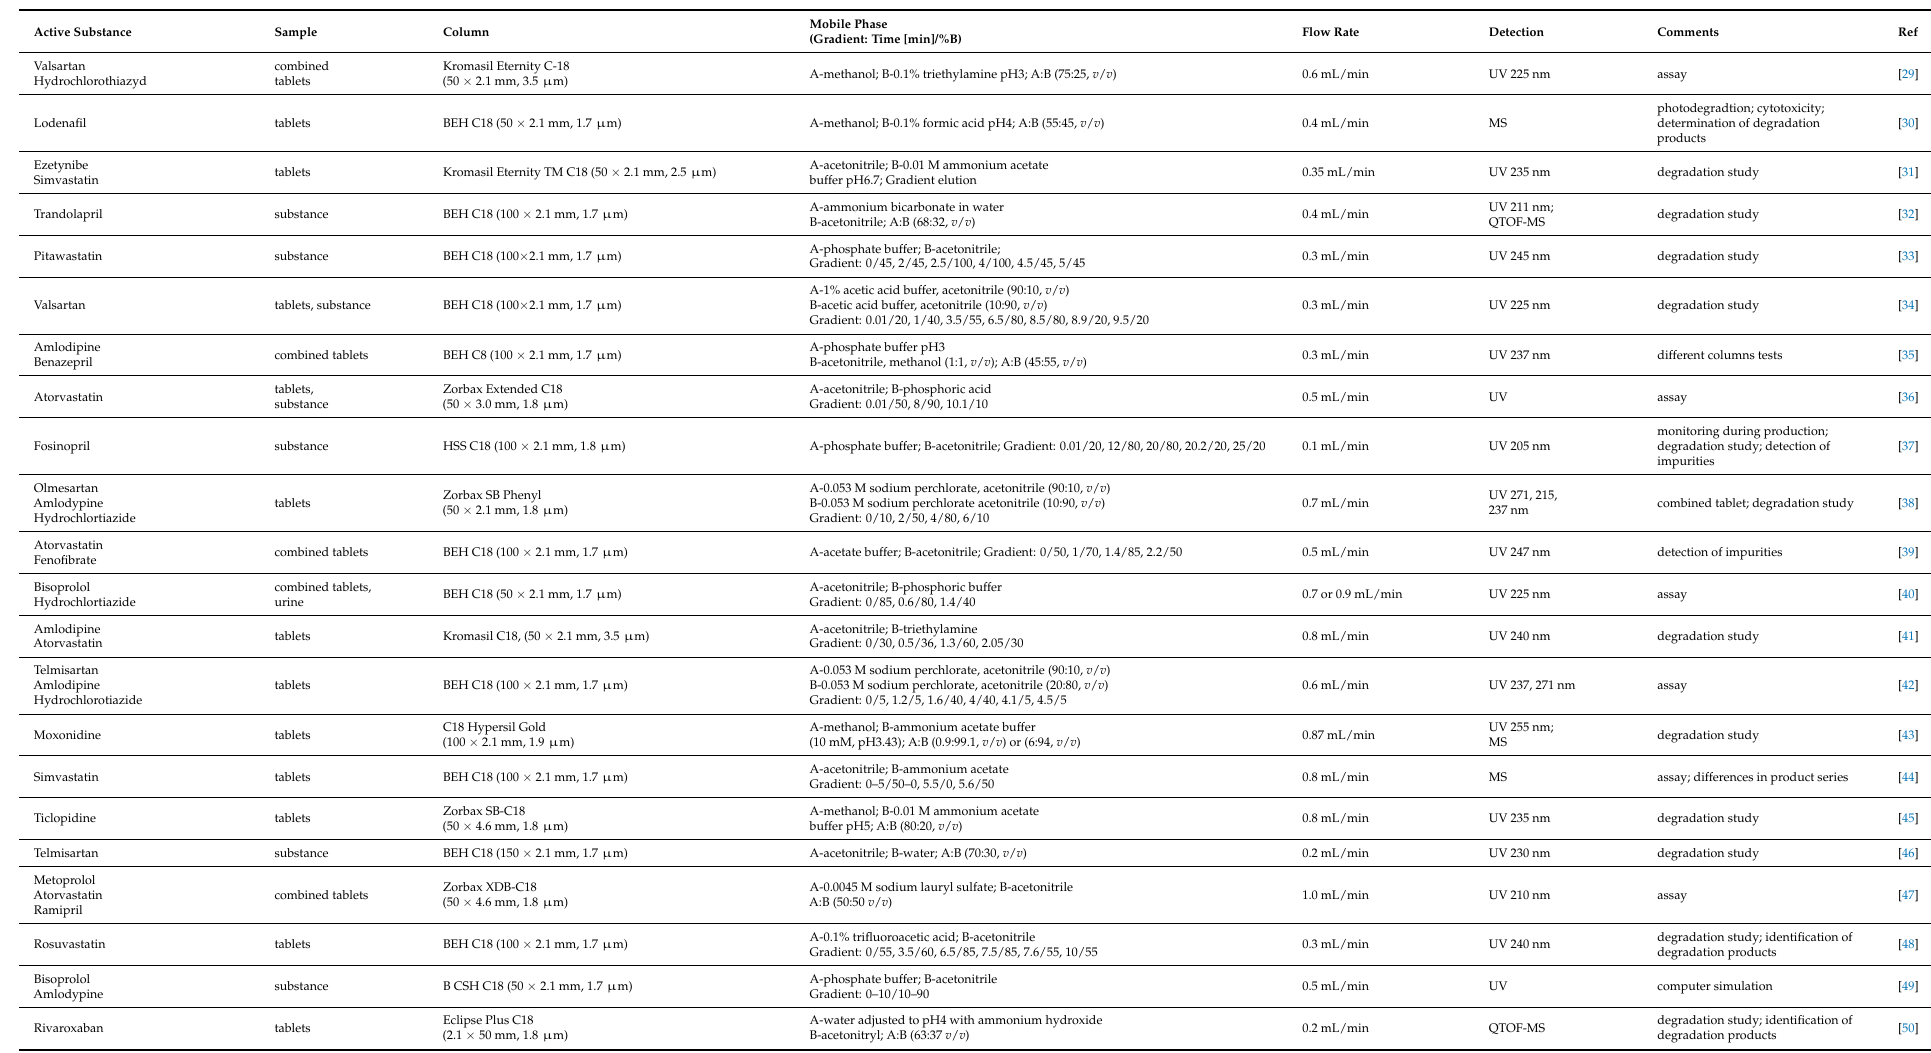
Table 1. UPLC technique in the analysis of cardiovascular